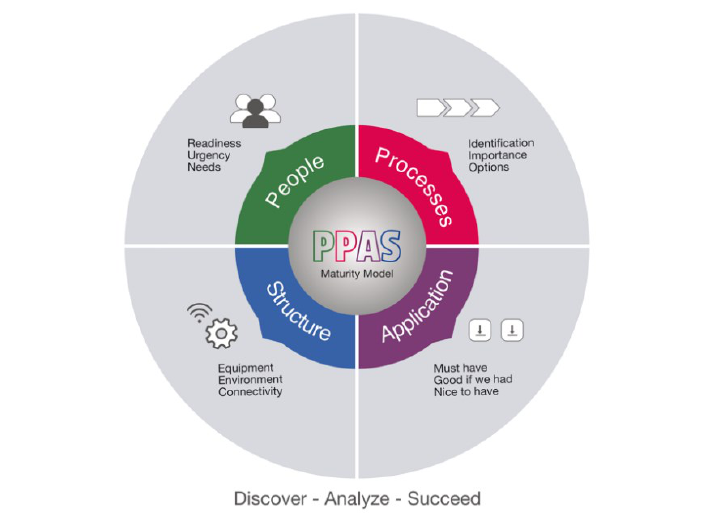
FIGURE 4. THE PPAS MATURITY